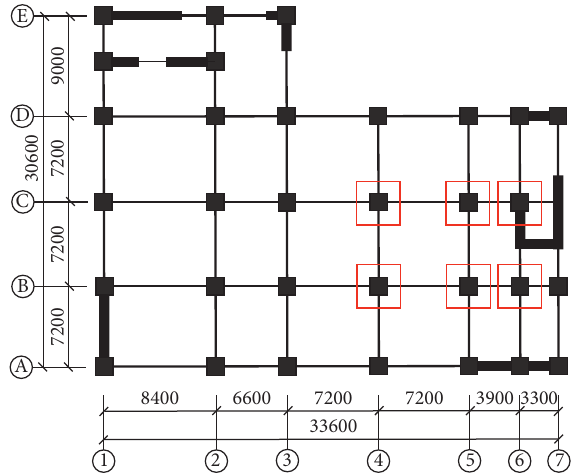
Figure 6: The structural plan of structure A (Unit: mm). Table 3: Main structural